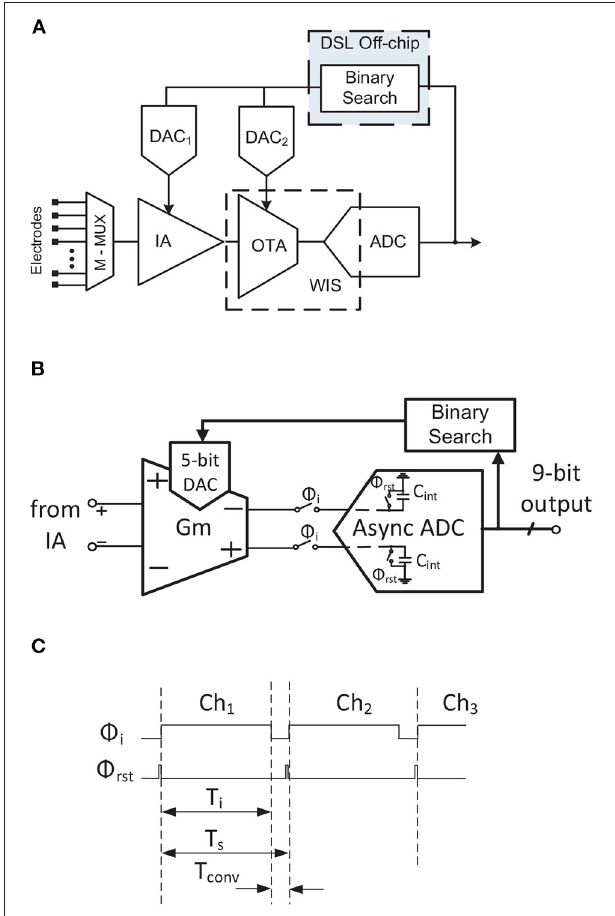
FIGURE 11 | TDM AFE proposed in Sharma et al. (2019). (A) Block diagram. (B) Simplified schematic of WIS and DC Servo Loop. (C) Simplified timing